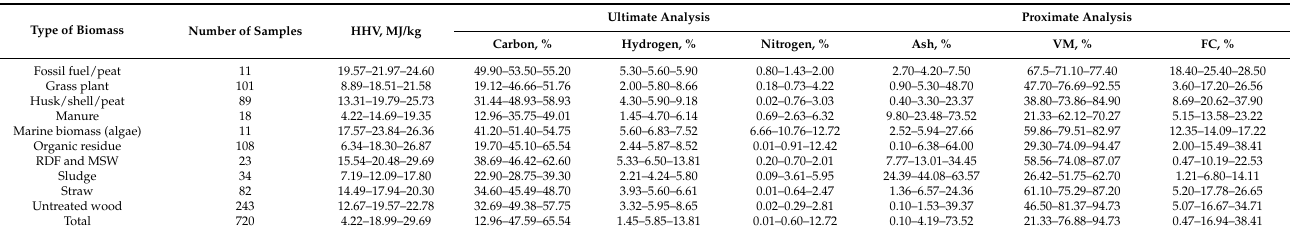
Table 1. Ultimate, proximate and HHV values (minimum–average–maximum values) used for the construction of ANN.